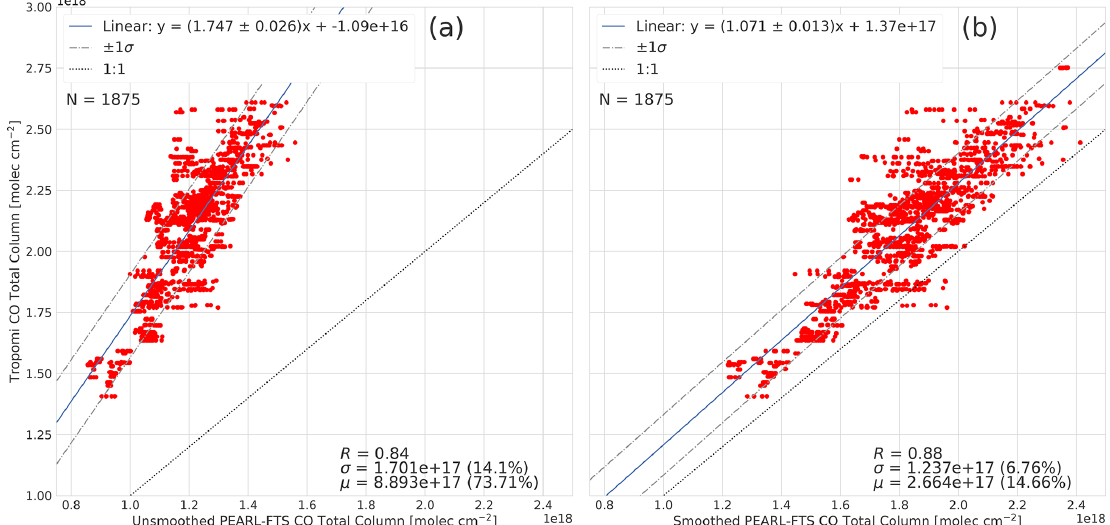
Figure 8. Correlation plots of TROPOMI CO total columns with (a) unsmoothed and (b) smoothed PEARL-FTS CO columns.